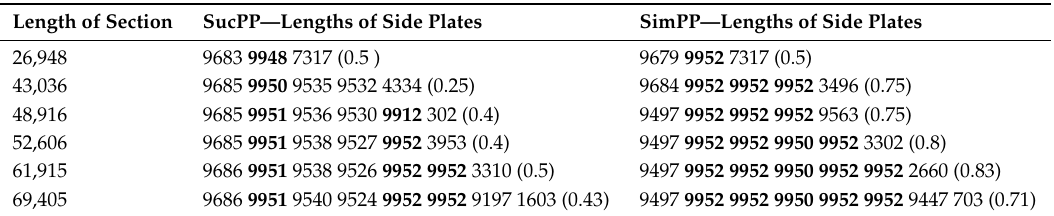
Table 2. Examples of resulting lengths of side plates, with MaxLength = 9952mm. Bold values indicate plates whose length is within 1% of MaxLength